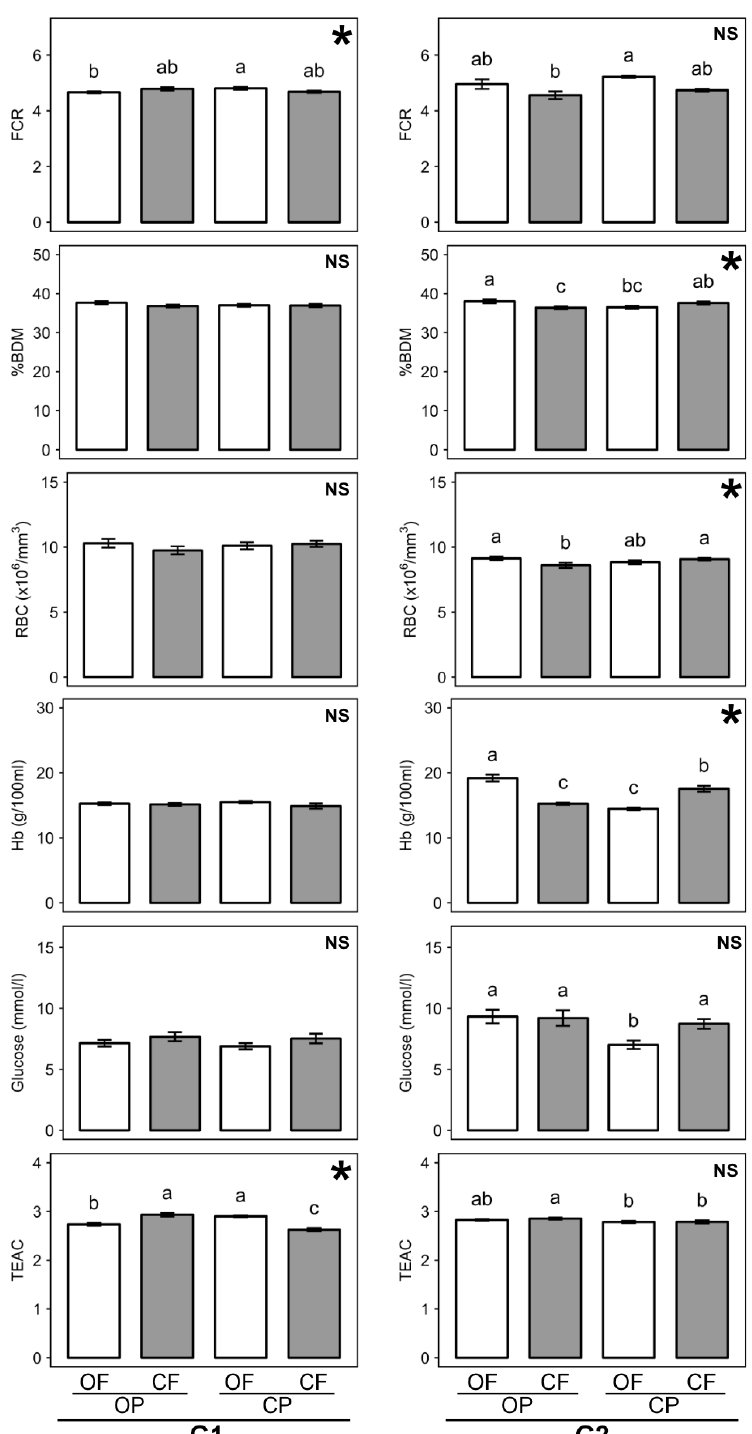
Figure 2. Effects of organic crop protection (OP) or conventional crop protection (CP) and organic fertility management (OF) or conven Table 1. and second ( G2 ) generation of rats. Results shown as means ± SEM of n = 24 animals, different letters above bars indicate significant difference ( p ≤ 0.05) determined by Tukey’s HSD test. * two-factor ANOVA detected a significant interaction between crop protection and fertilization regimes.